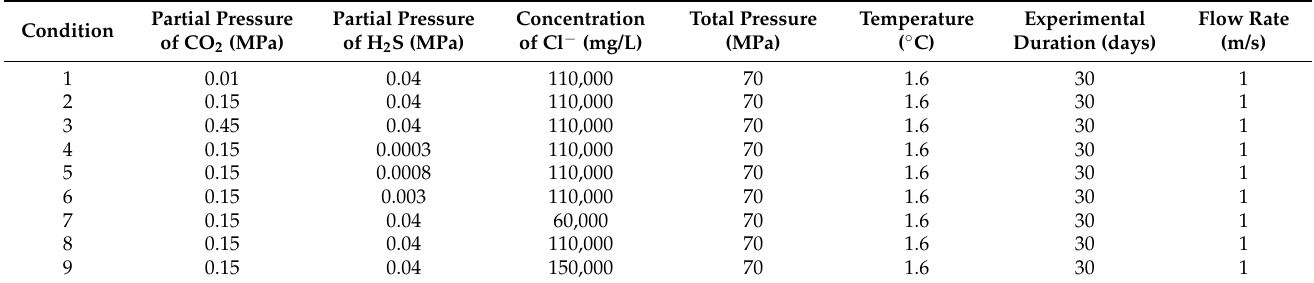
Figure 14. Corrosion rate of 20# steel and BX245-1Cr steel. Table 17. Experimental